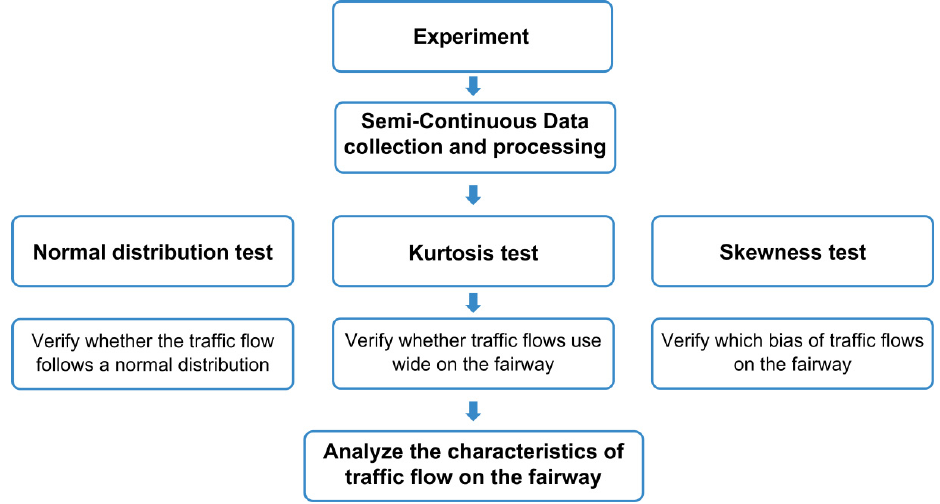
Figure 2. Semi-continuous spatial statistical analysis methodology.